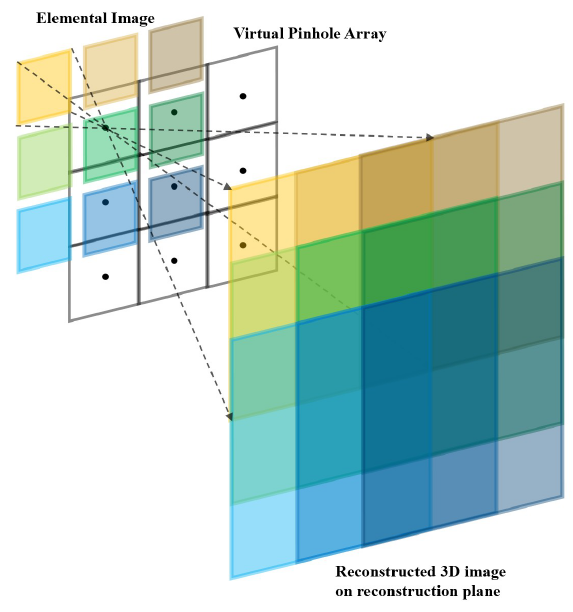
Figure 2. Volumetric computational reconstruction